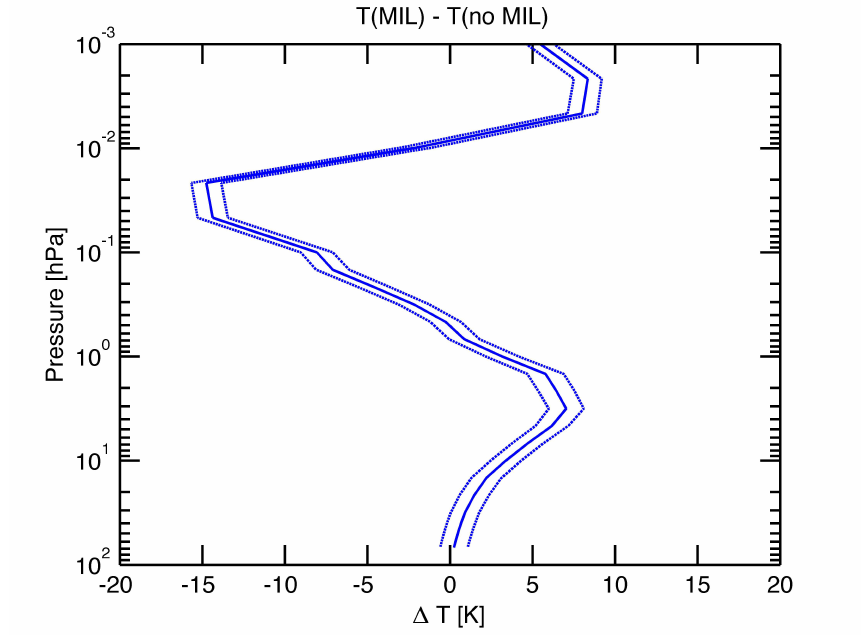
Figure 3. Temperature difference profile for “MIL” minus “no MIL”. A 5–7 K increase of temperature is present in the upper stratosphere at 2 hPa during an MIL. Dashed lines show the error of the mean.